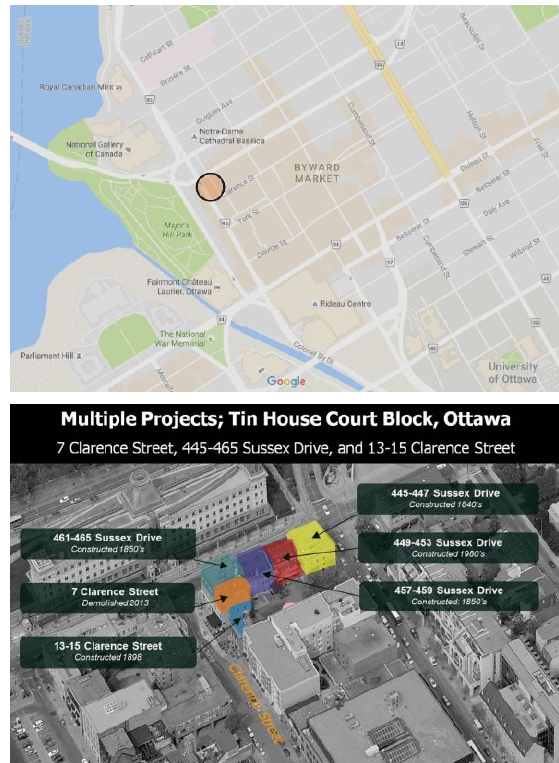
Figure 1: Site location within the Byward Market in Ottawa, and aerial view indicating the set of buildings. Sources: Google maps and NCC, 2016.